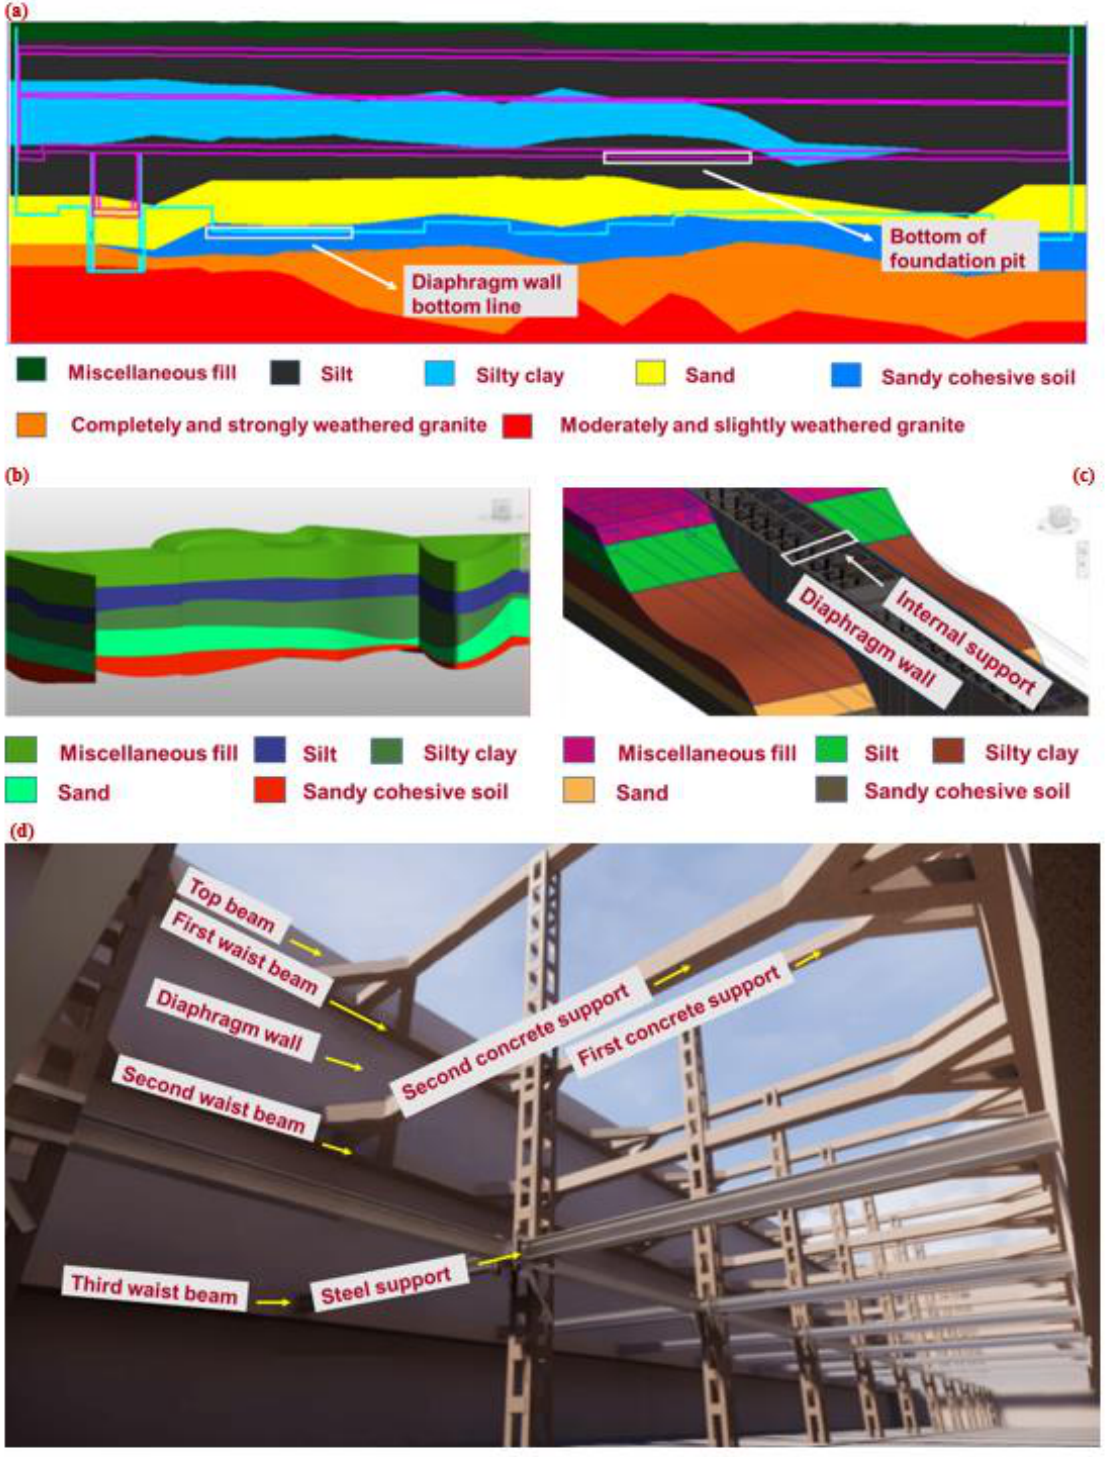
Figure 4. Modeling the diaphragm wall and internal support structure in the soil layer and deep foundation pit. ( a ) site geological longitudinal section; ( b ) in situ 3D transparent geological model; ( c ) model of diaphragm wall and internal support structure in deep foundation pit; ( d ) final rendering effect of foundation pit.